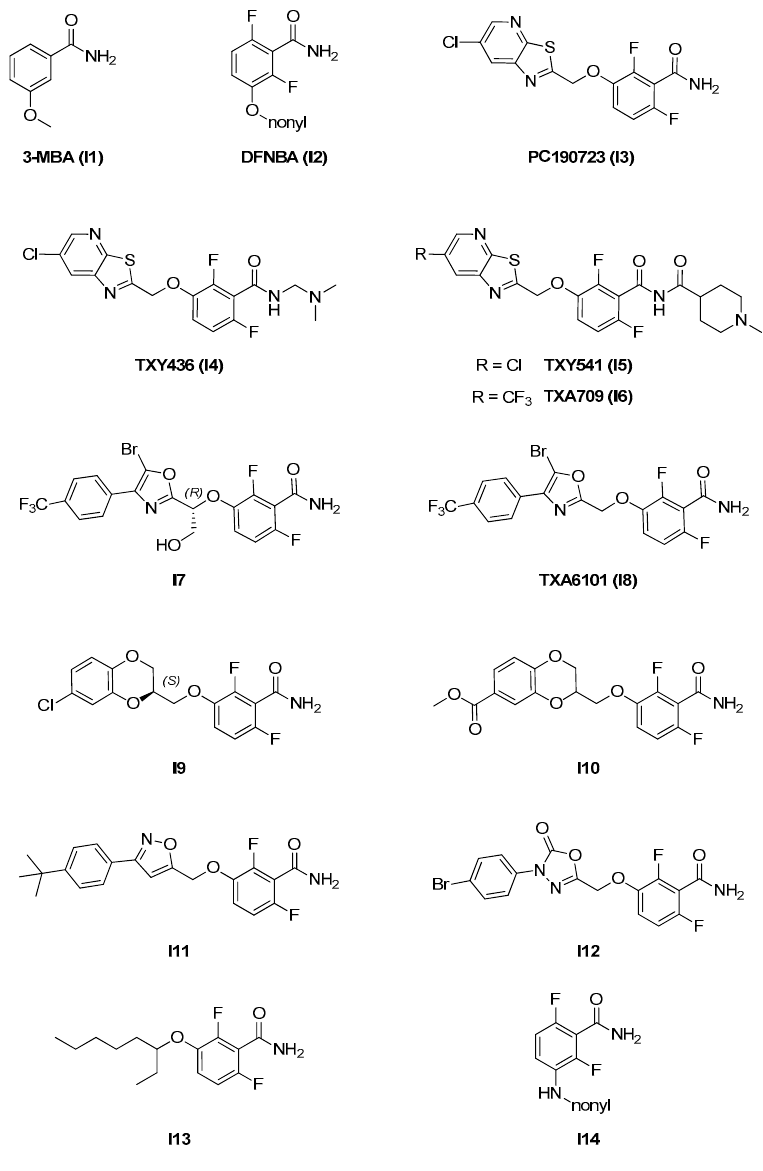
Figure 7. Benzamide inhibitors.